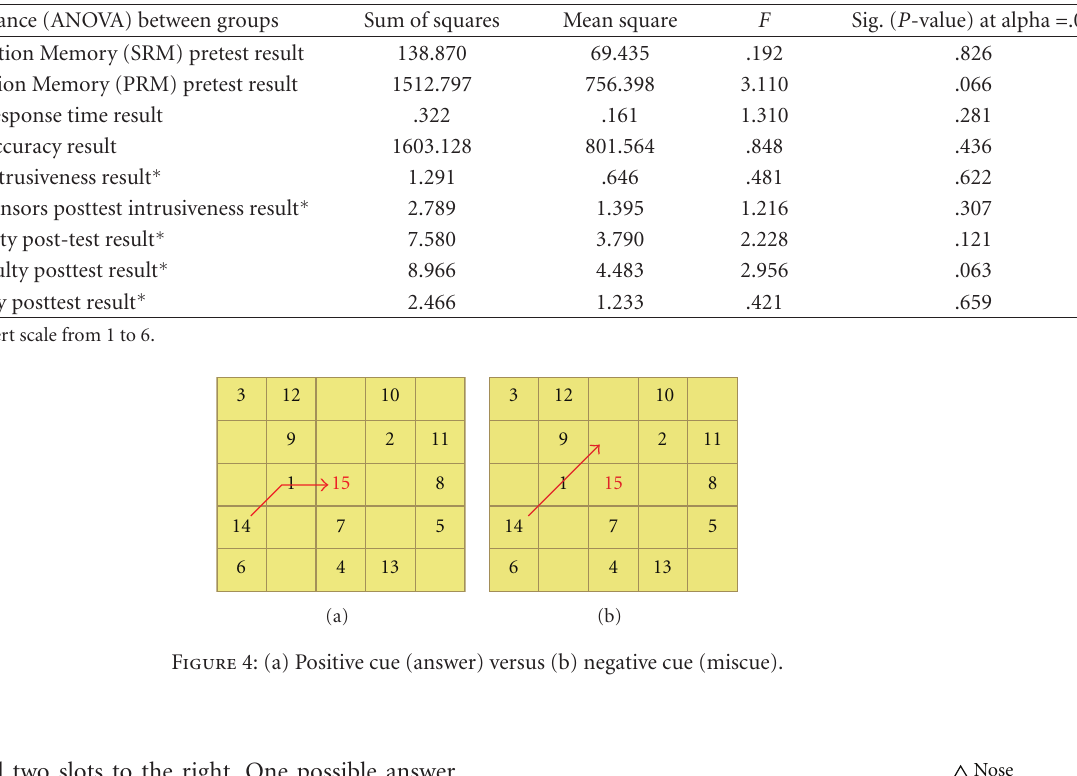
Table 2: No significant di ff erence found between participants’ pre- and posttests results.